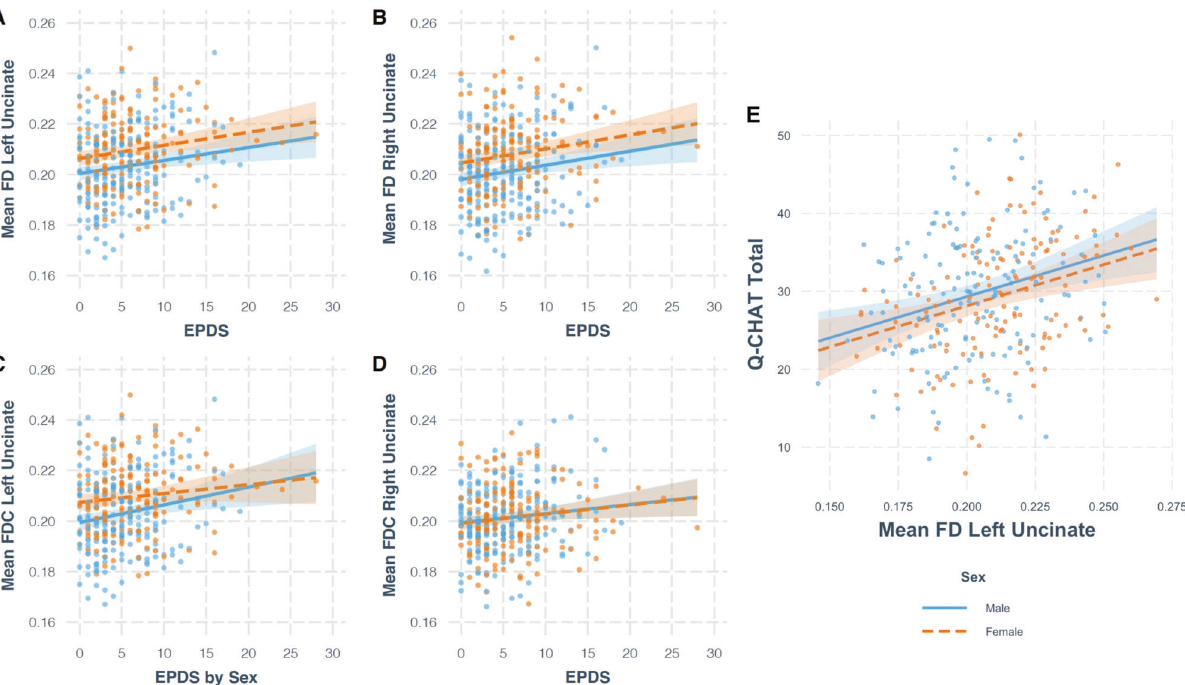
Fig. 2 Plots showing the relationships between variables of interest. A – D Contain plots showing the relationship between EPDS and white matter microstructure and macrostructure, controlling for effect of covariates. For mean FD left ( A ) and right ( B ) uncinate fasciculus and mean FDC right uncinate fasciculus ( D ), the main model is plotted. For mean FDC left uncinate fasciculus ( C ), the model with EPDS by Sex interaction is plotted. The relationship between EPDS and mean FD in the left and right uncinate fasciculus ( A , B ) survived FDR correction. E Contains a plot from robust regression, showing the relationship between mean FD in the left uncinate fasciculus and total Q-CHAT score, controlling for the effect of Infant white matter microstructure and behaviour in toddlerhood Results from robust regression suggested that infant FD in the uncinate fasciculus had a positive main effect on Q-CHAT scores (B = 105.70, p = 0.0007 for left, B = 70.45, p = 0.020 for right), so that infants with higher FD in this tract had higher Q-CHAT scores at 18 months (Fig. 2). The results for the left uncinate fasciculus survived FDR correction for multiple comparisons ( q = 0.004), while results for the right uncinate fasciculus did not ( q = 0.06). There were no FBA by sex interactions. There were no associations between infant FD in the uncinate fasciculus and CBCL internalising and externalising scores (see Supplementary). These results are consistent with those obtained using traditional regression methods (see Supplementary). Sensitivity analyses . Results from a sensitivity analysis suggested comparable results for mean FD when controlling for postnatal home environment (B = 107.45, p = 0.0006 for left, and B = 71.09, p = 0.020 for right uncinate fasciculus), as well as when controlling for dysfunctional parenting (B = 93.34, p = 0.002 for left, and B = 61.86, p = 0.036 for right uncinate fasciculus). Mediation EPDS scores predicted total Q-CHAT scores, with B = .342, t(307) = 3.003, p = 0.003. However, there was no evidence that FD in the left uncinate fasciculus mediated the relationship between maternal EPDS and total Q-CHAT scores (Sobel test z = 1.46, p = 0.143, bootstrapped indirect effect = 0.035, SE = 0.02, 95% CI [ − 0.01 − 0.08]) (see Supplementary).